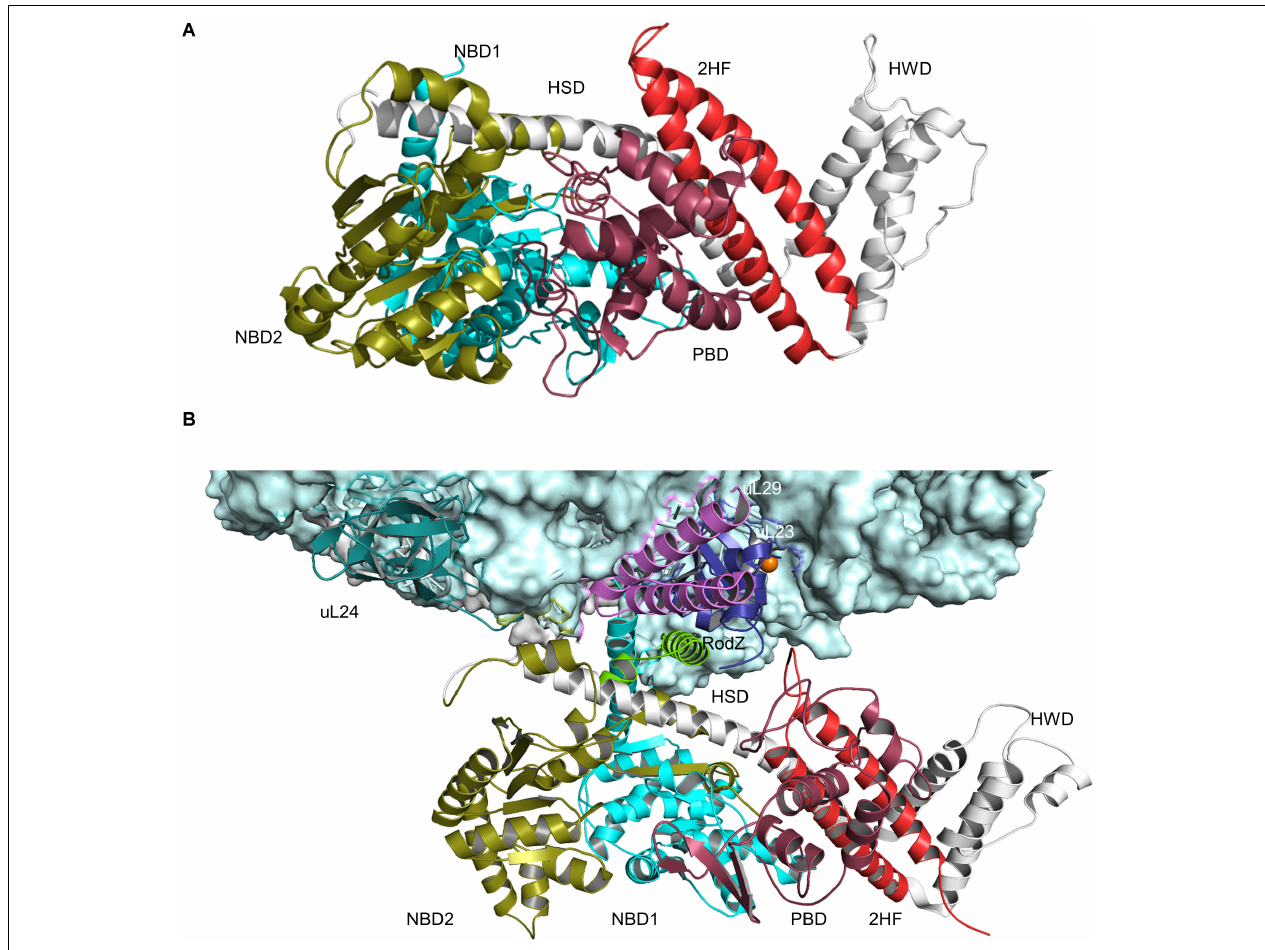
FIGURE 3 | Structures of SecA and SecA bound to the ribosome. (A) Structure of B. subtilis SecA (PDB 5EUL), showing its multiple domains. The two nucleotide-binding domains NBD1 and NBD2 are shown in cyan and in olive, respectively. The peptide-binding domain (PBD) is shown in raspberry-red, the helical wing domain (HWD) and the helical scaffold domain (HSD) in gray and the two-helix finger (2HF) in red. (B) Structure of E. coli SecA bound to a translating ribosome (PDB 6S0K). The 50S ribosomal subunit is shown in light-blue and the nascent RodZ chain in green. Ribosomal proteins that are in contact with SecA [uL23 (blue), uL29 (pink), and uL24 (green)] and the different domains of SecA are labeled and shown in the same color-code as in (A)